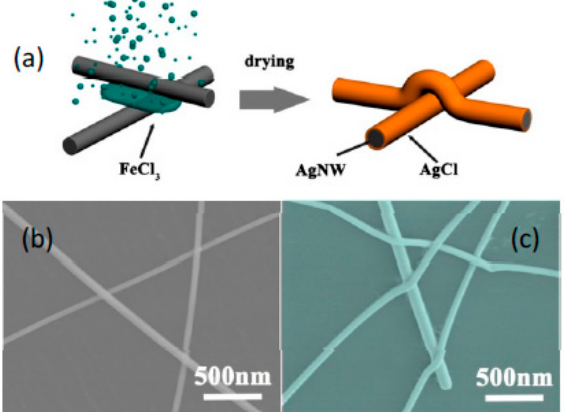
Figure 9. Sheet resistance variation of the films under bending tests ( a ) of bending cycle under a bending radius of 1 cm, and ( b ) with a bending radius of 1.5, 1, and 0.5 cm, respectively, under 5000 bending cycles. The insert in ( a ) is the repeated bending test picture with a bending radius of 1 cm. The insert in ( b ) are the bending test pictures for 5000 times with a bending radius of 1.5, 1, and 0.5 cm.